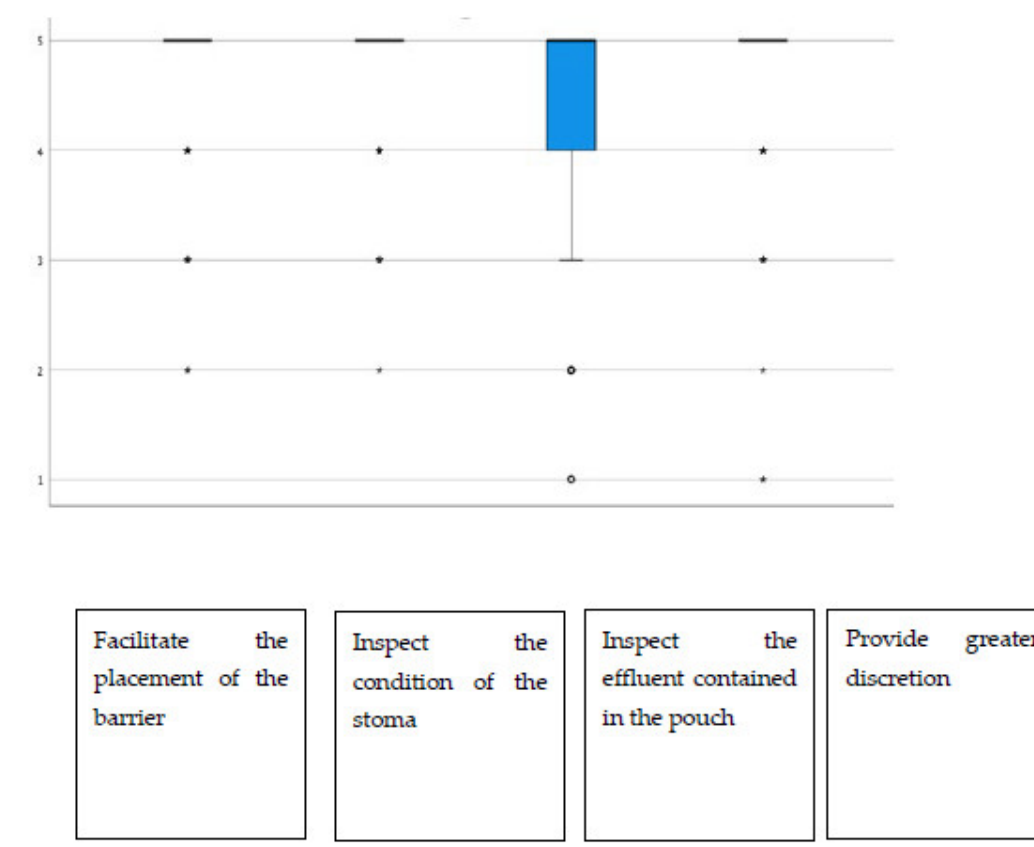
Figure 2. Distribution of scores in the utility rating of the display window.